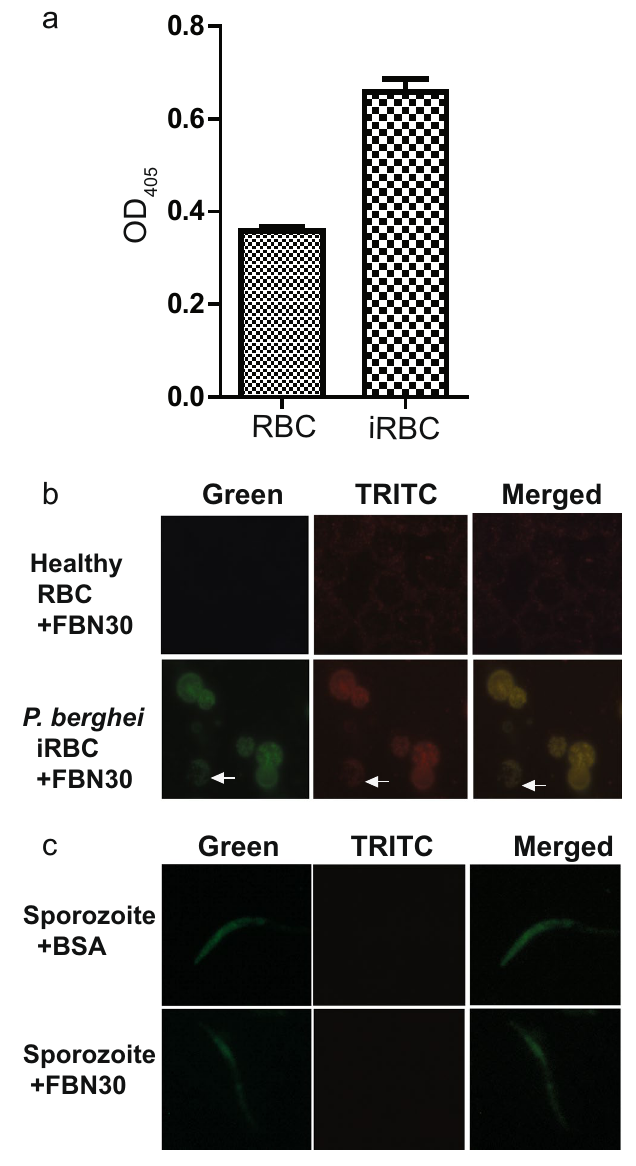
Figure 2. FBN30 binds to P. berghei infected red blood cells and ookinetes. ( a ) Interaction between the recombinant FBN30 protein and P. berghei iRBC by ELISA. The lysates of P. berghei -infected red blood cells (iRBC) and uninfected mouse red blood cells (RBC) were used to determine the interaction between FBN30 and P. berghei parasites. OD 405 values and standard deviations were obtained from 3 replicates. The OD 405 value in P. berghei iRBC was 1.86 folds of the uninfected mouse RBC, and the difference is significant ( p < 0.01). ( b) Interaction between FBN30 protein and P. berghei parasites determined by indirect immunofluorescence assays (IFA). Images in the first row represent non-infected mouse RBCs. Images in the second row represent mouse P. berghei iRBCs and ookinetes. Images in the third row obtained by merging first and second rows to show the co-localization of FBN30 and parasites. Arrows show the location of P. berghei gametocytes. ( c ) FBN30 does not bind to P. berghei sporozoites as determined by IFA. Images in the first row are the control group by replacing FBN30 with equal amount of BSA in IFA assays. The first and second columns show P. berghei parasites (green color) and FBN30 (red color) respectively. Merging column one and two generated the third